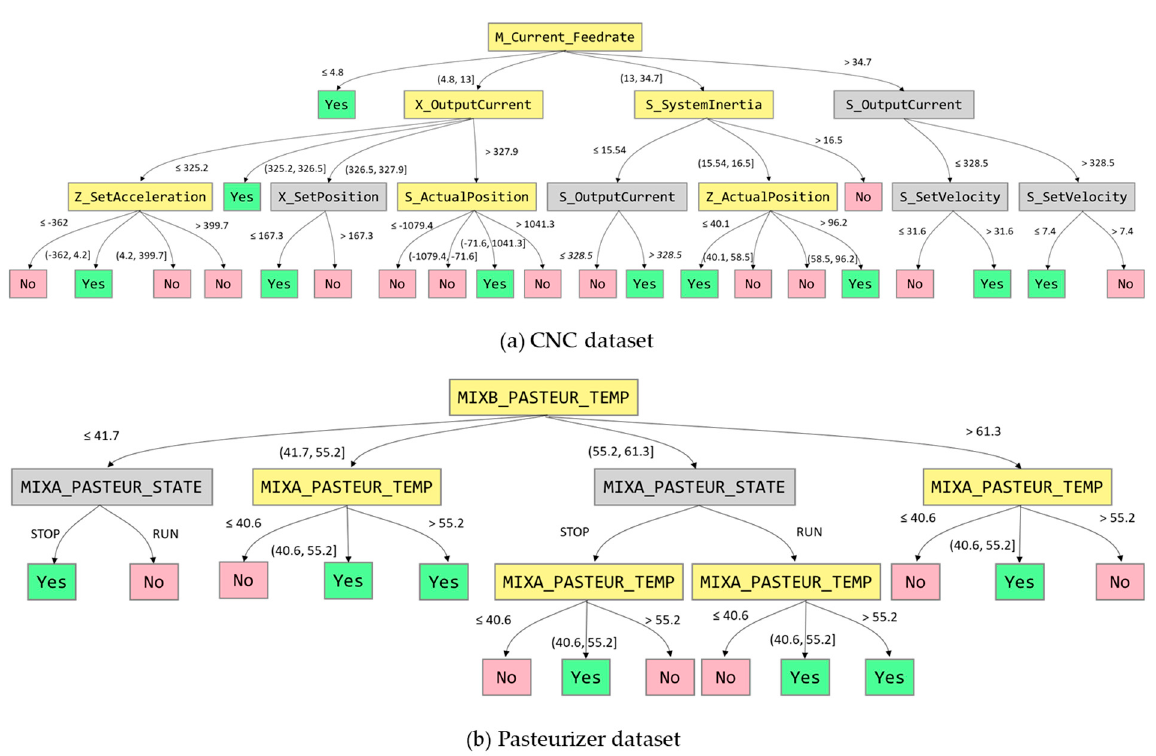
Figure 6. Illustration of two decision trees improved by DIMPLED. The decision trees contain discretized attributes highlighted in yellow, which have multiple branches.